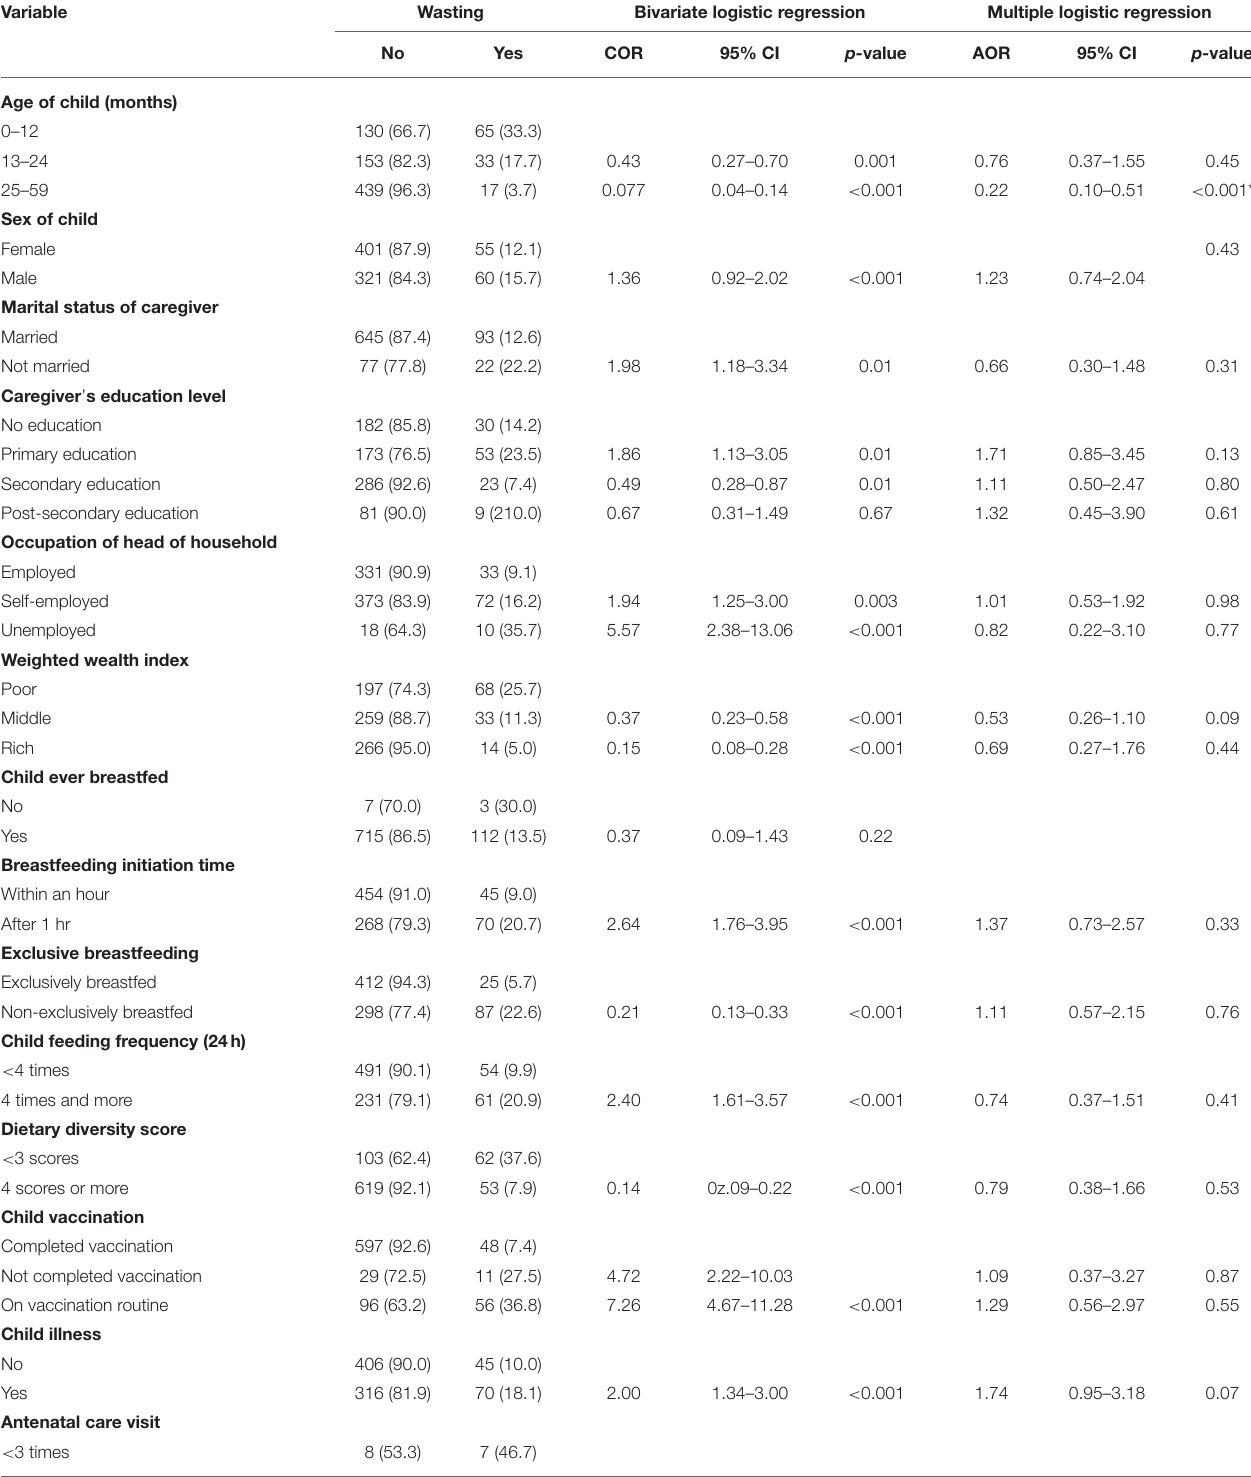
TABLE 3 | Bivariate and multiple logistic regression for factors associated with wasting (WHZ < − 2SD) among children age 0–59 months in Bambao region, July 2021 ( N = 837). Variable Wasting Bivariate logistic regression Multiple logistic